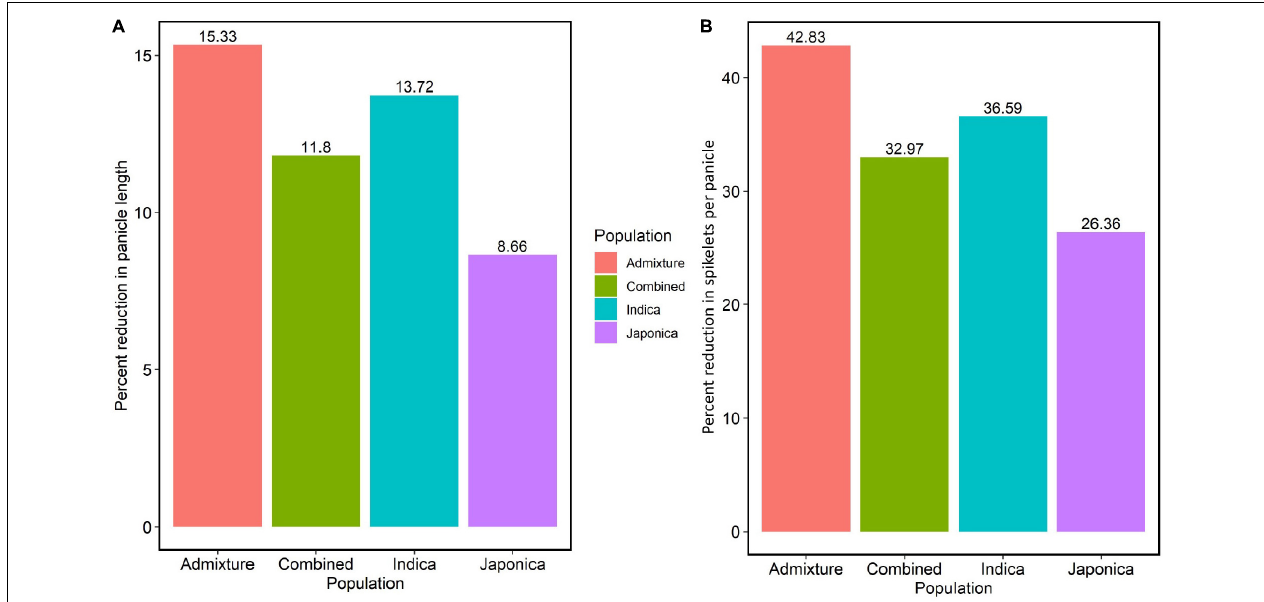
FIGURE 2 | The effect of HNT stress on PL in cm and NSP in the panel of 190 diverse rice accessions of the URMC. (A) Percent reduction in PL in the Admixture, Combined, Indica, and Japonica subpopulations under HNT stress. (B) Percent reduction in NSP in the Admixture, Combined, Indica, and Japonica subpopulations under HNT